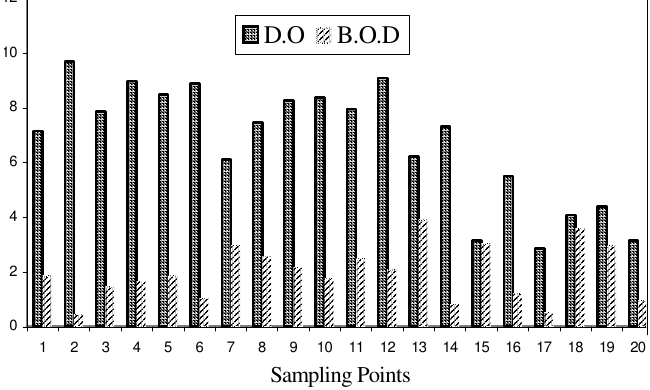
Figure 3. D.O and B.O.D values of various groundwater samples collected from Delhi.